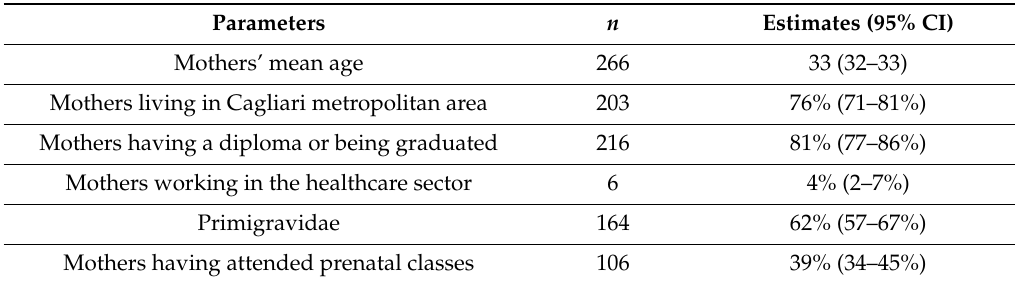
Table 1. Description of the